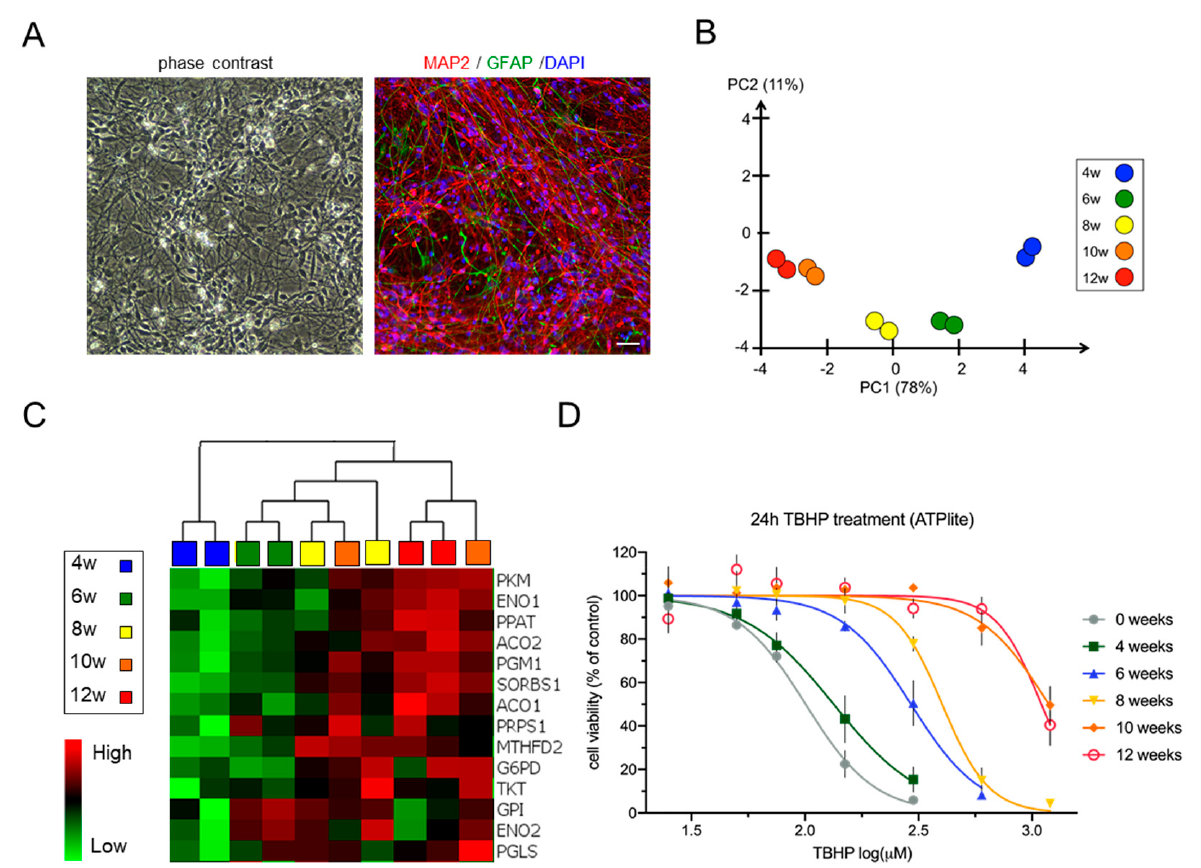
Figure 1. Neural differentiation of lt-NES cells is characterized by changes in metabolic pathway gene expression and increasing resistance to stress. ( A ) Phase contrast picture and a representative immunofluorescence staining of 8-week-differentiated lt-NES cells stained for MAP2 and GFAP. Scale bar, 100 µ m. ( B ) Principal component analysis of differential gene expression in lt-NES cultures differentiated for 4, 6, 8, 10 and 12 weeks based on 1919 variables, showing clustering of the samples according to differentiation time. ( C ) Heatmap of glucose metabolism-associated gene expression showing upregulation of neuron-specific glycolysis genes (e.g., PKM , G6PD , ENO1 ) and pentose phosphate pathway (PPP)-associated genes (e.g., TKT , PGLS ) with time of differentiation. Data were generated using an Affymetrix transcriptome microarray ( n = 2). ( D ) Resistance to TBHP treatment increases with differentiation. Proliferating and differentiated lt-NES cells were treated with TBHP for 24 h. Toxicity was assessed by ATPlite assay at the end of the treatment phase with the indicated concentrations. Shown are measurements of the response to TBHP (after 24 h) of undifferentiated, 4, 6, 8, 10 and 12 weeks differentiated lt-NES cells, presented as percentages relative to untreated cells (equal to 100%). Data are presented as means ± SEM ( n ≥ 3 per differentiation time point, consisting of at least 4 technical replicates each).